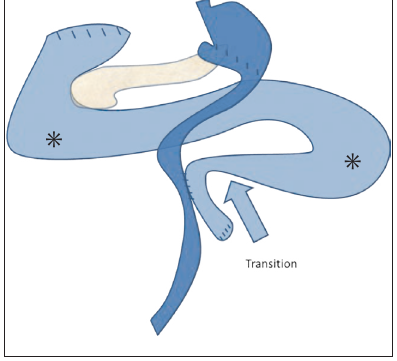
Fig. 5. Transition point (broad arrow) with distended afferent duodeno-jejunal limb (*).